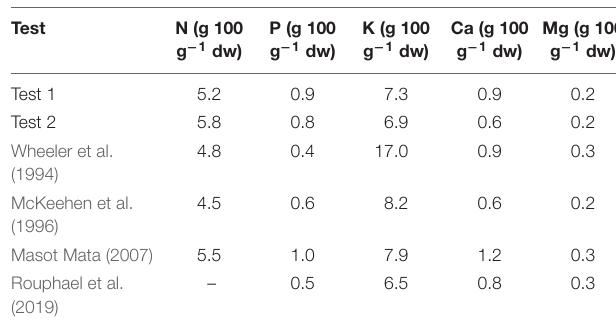
TABLE 2 | Comparison of shoot mineral copmposition of hydroponically-grown lettuce plants coming from Test 1 and Test 2 with scientific